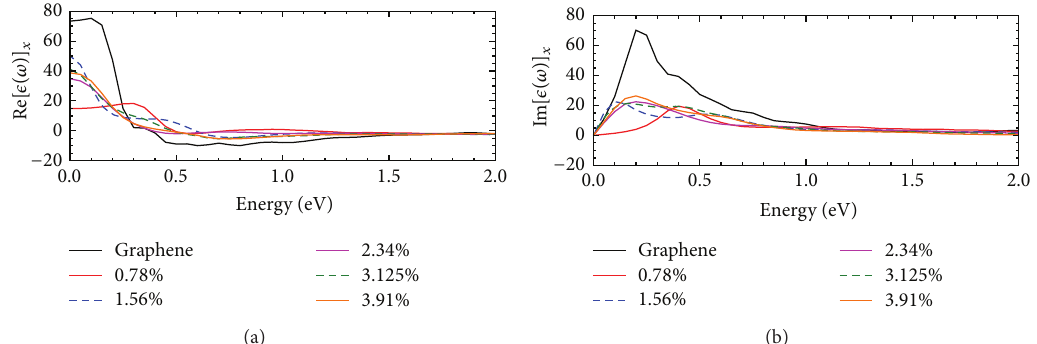
Figure 5: Simulated real (a) and imaginary (b) 𝑥 -axis components of dielectric response for the various concentrations of gallium (0, 0.78, 1.56, 2.34, 3.13, and 3.91%). This is the average dielectric response consisting of a five-point configuration average. The average dielectric response along 𝑦 -axis is